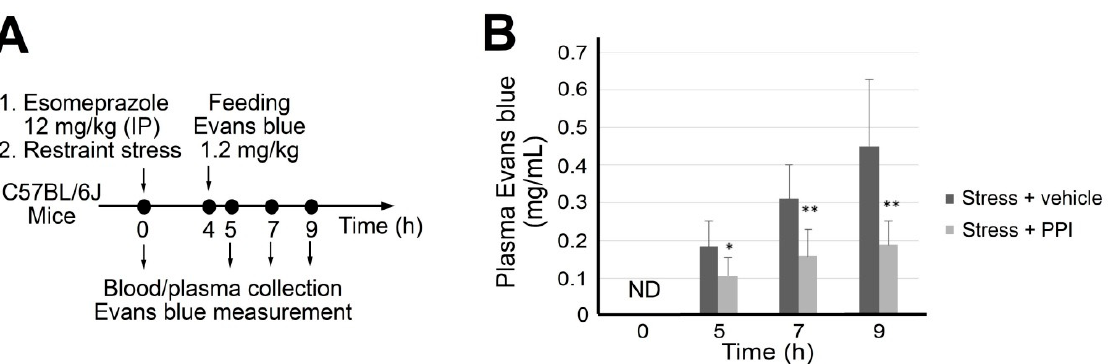
Figure 3. Proton pump inhibitor (PPI) rescues stress-induced GI leakage. ( A ) Experiment outline of PPI esomeprazole treatments in the restraint stress mouse model. ( B ) Plasma Evans blue levels of stressed mice with or without esomeprazole treatments at 0, 5, 7, and 9 h. Error bars show the standard deviation; * p < 0.05 and ** p < 0.01 vs. their respective control groups without esomeprazole treatments. ND: not detected. n = 6 (3 experiments with a total of 6 mice per group).